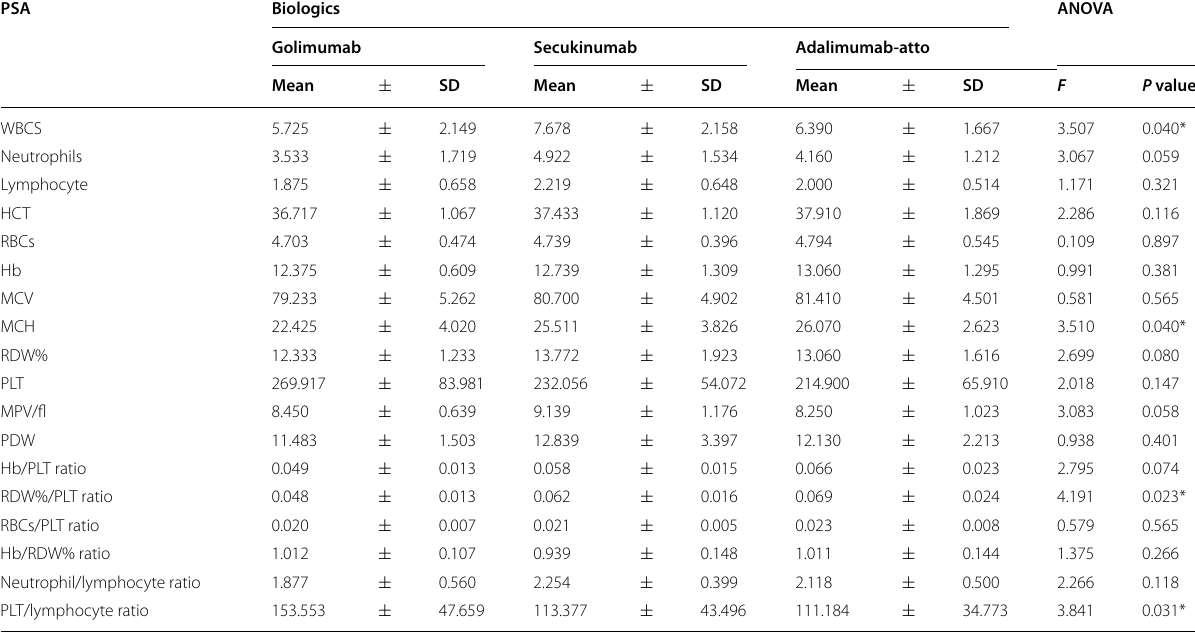
Table 5 Comparison between different types of biologics in PsA as regards WBCs, RBCs, and platelets indices